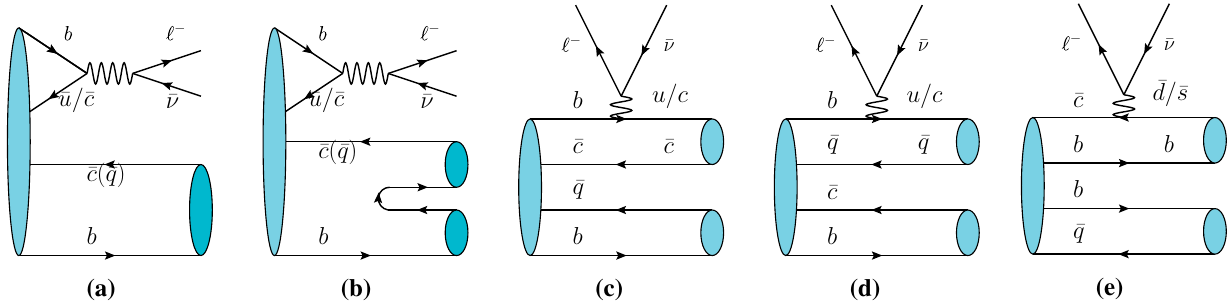
{ bb } {¯ c ¯ q } semi-leptonic decays into mesons. a Represents the one meson in final states. b – e Show